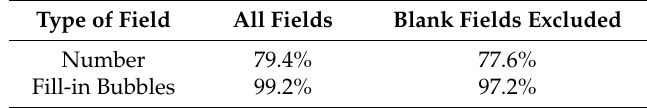
Table 1. Measurement of accuracy rates for recognition of fill-in bubbles and number boxes.